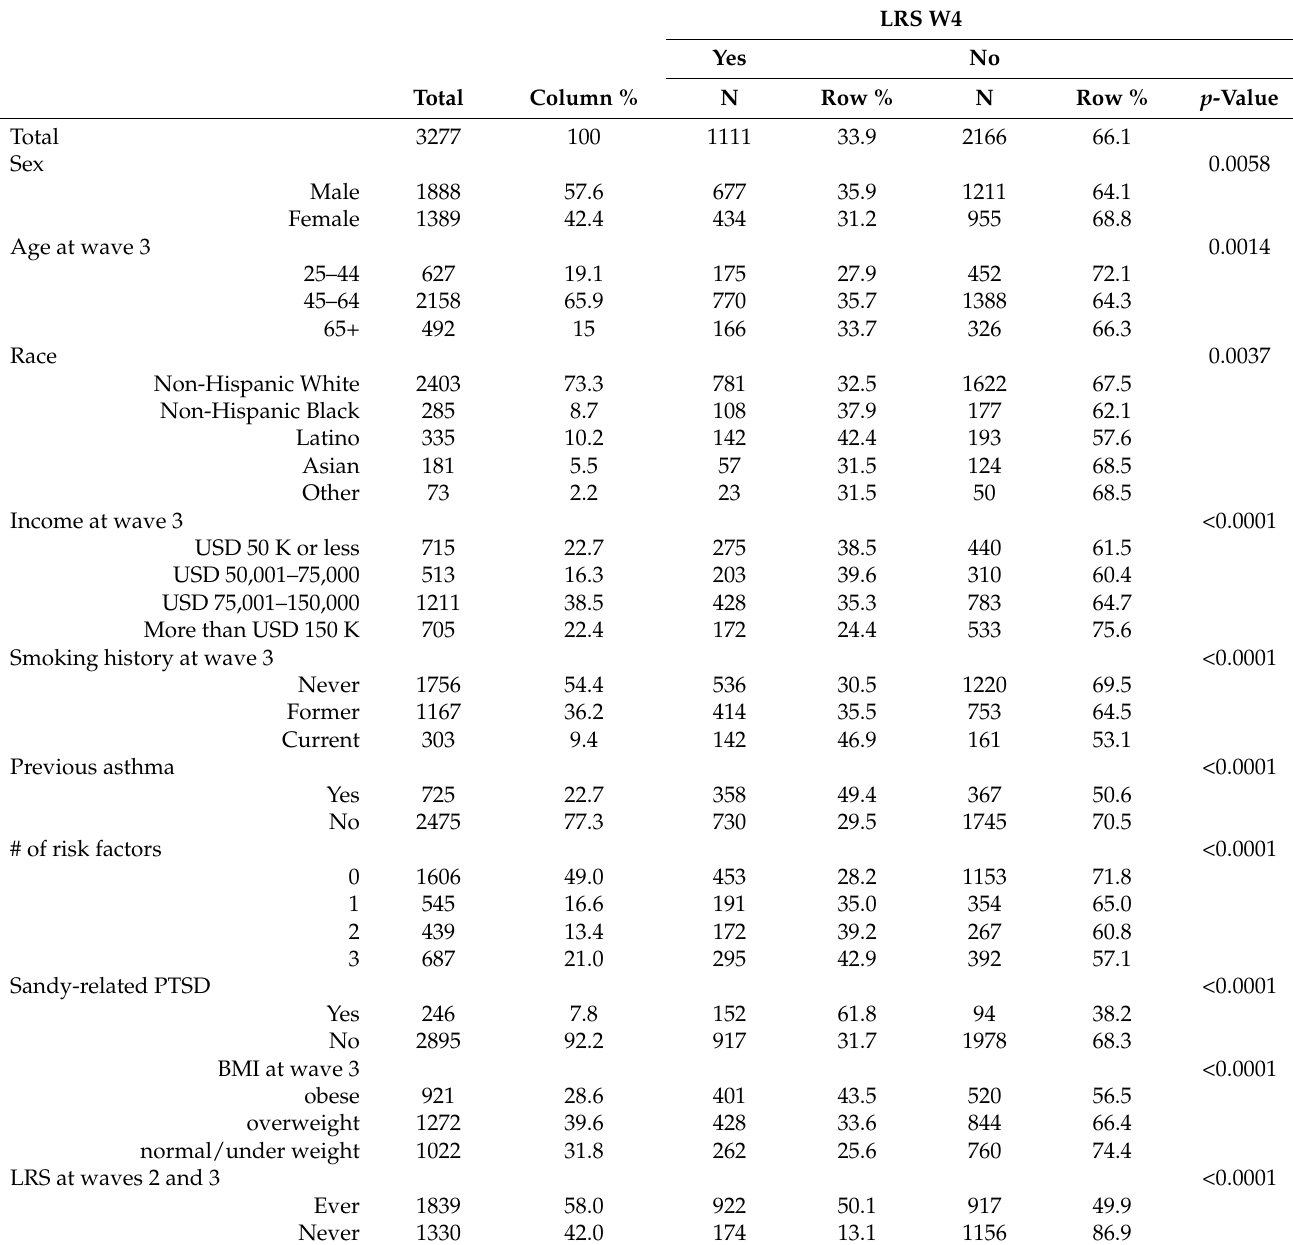
Table 1. Characteristics of survey participants and prevalence of Lower Respiratory Symptoms (LRS) after Hurricane Sandy among the World Trade Center Health Registry